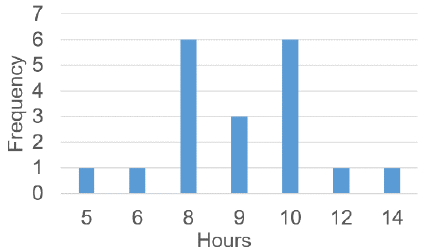
Figure 6. Completion time of the educational material